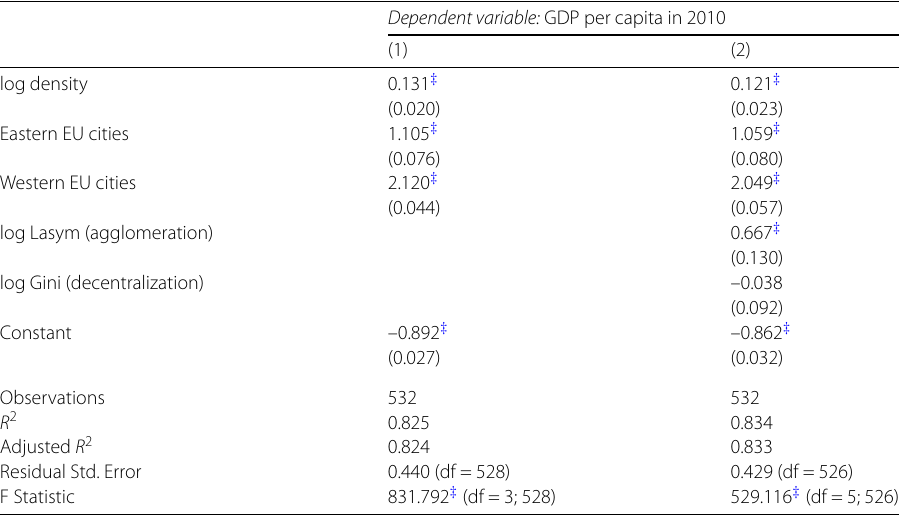
Table 1 Ordinary least squares (OLS) test on GDP per capita for EU and Chinese cities in 2010. Standard errors are shown in parentheses (all non-dummy location variables are mean-centered) Dependentvariable: GDP per capita in